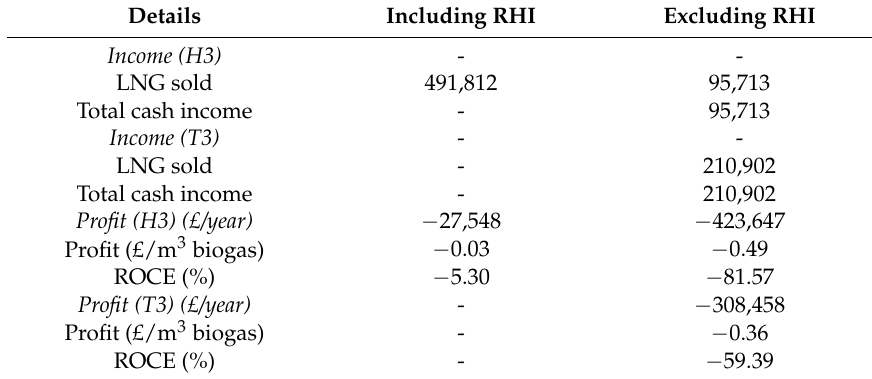
Table A6. Income, profit and ROCE for conventional upgrading of biogas for use as LNG (routes